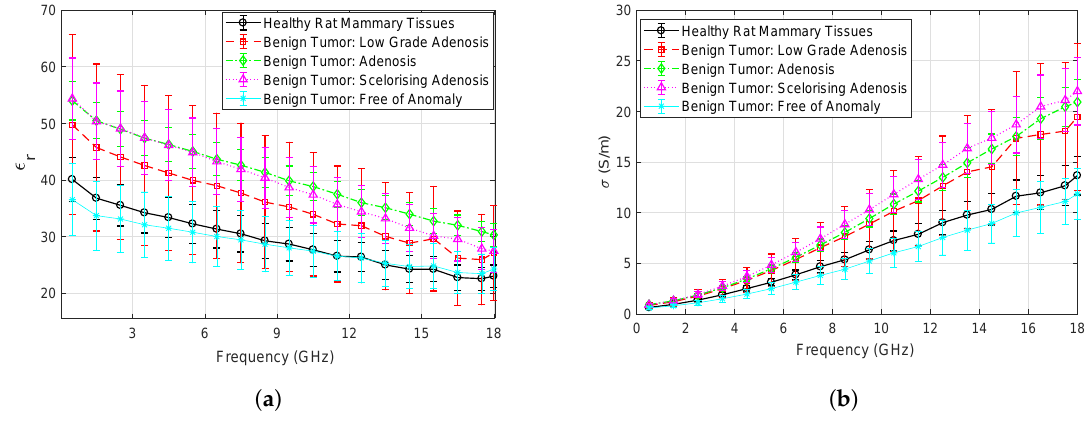
Figure 3. In vivo dielectric property measurement results of rat mammary tissues with error bars indicating the standard deviation: ( a ) Comparison of relative permittivity measurements collected from benign tumor and healthy tissues; ( b ) Comparison of conductivity measurements collected from benign tumor and healthy tissues.